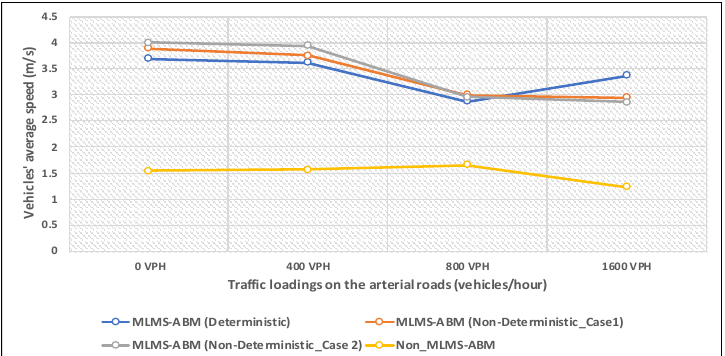
Figure 11. Average vehicle speeds with different arterial loads (hypothetical road network).